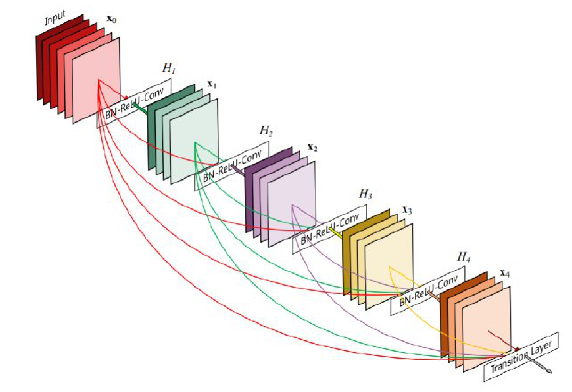
Figure 8. The structure of DenseNet [21] block shown in [22]. Features are added from all preceding